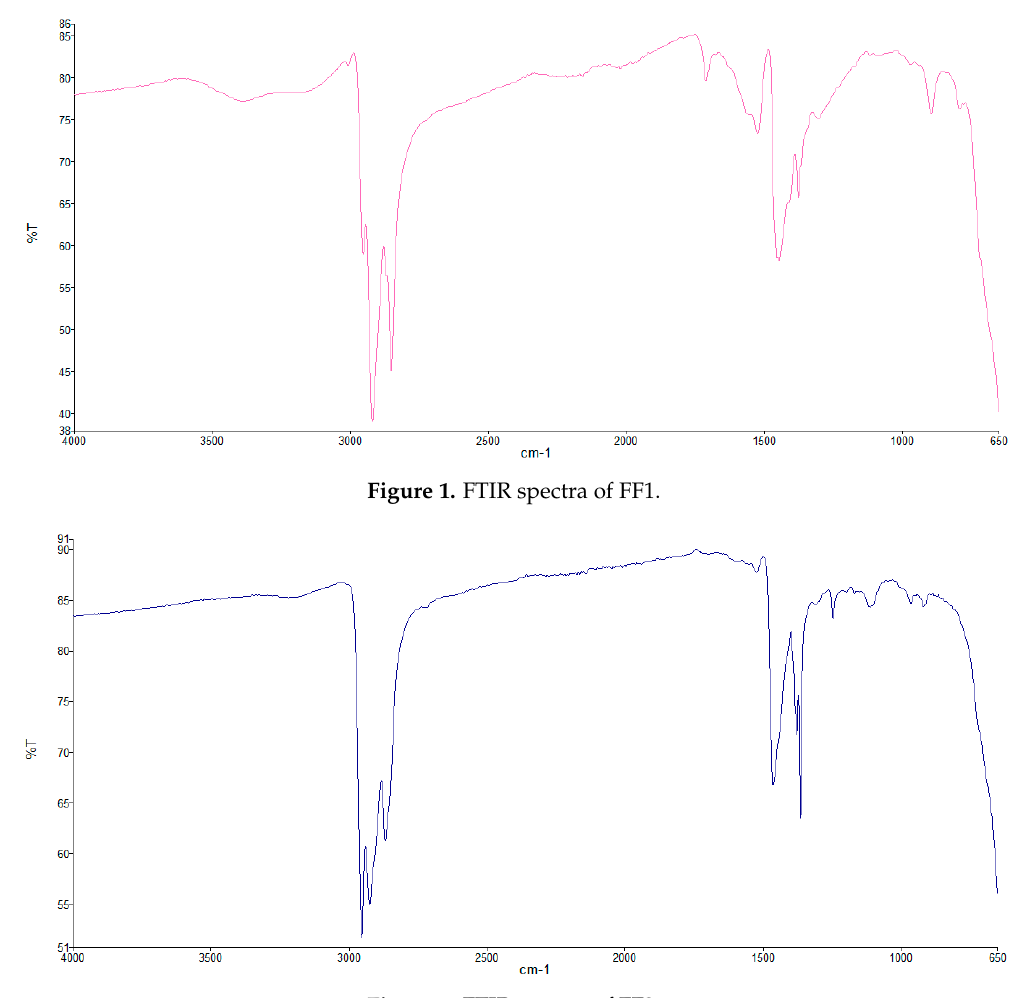
Figure 2. FTIR spectra of FF2.